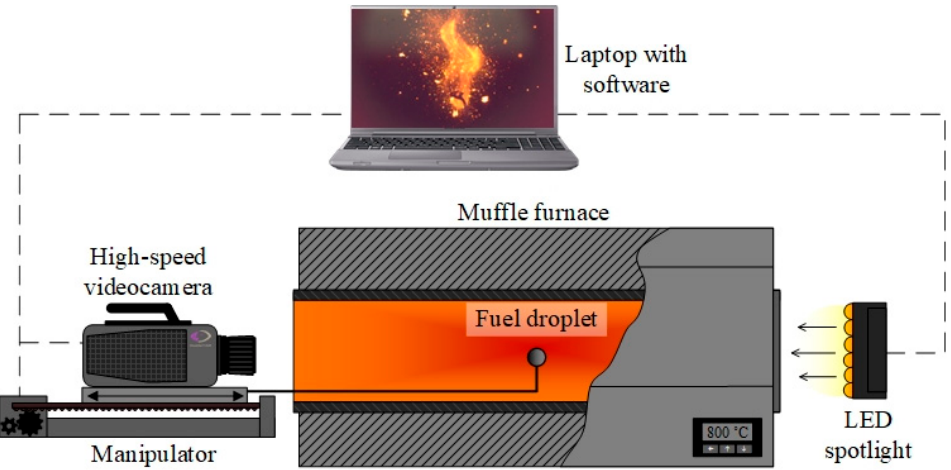
Figure 1. Scheme of the experimental